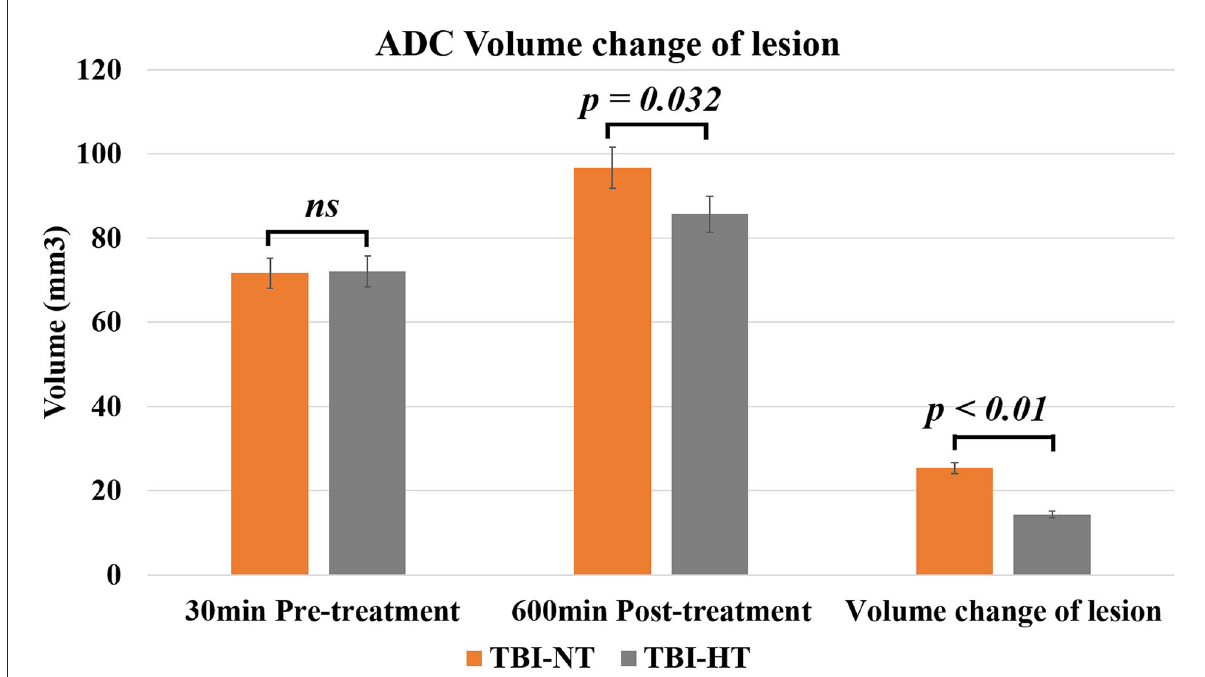
FIGURE5 The histogram depicts the ADC volume difference of traumatic lesions before and 10h after therapeutic hypothermia or normothermia. Data in Figure 5: TBI-NT n = 8, TBI-HT n = 8. All n values refer to the number of rats used, and the error bars depict the mean ± s.e.m. P -values were calculated by the Mann–Whitney U- test, and P < 0.05 indicates